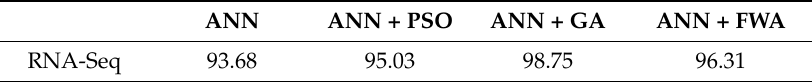
Table 8. Accuracy of RNA-Seq in ANN and the three algorithms.